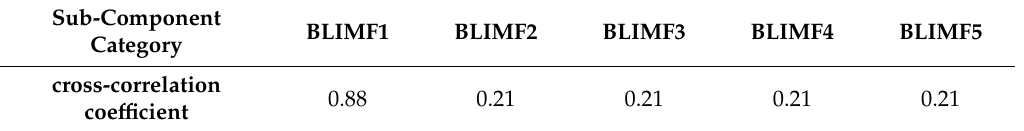
Table 1. Statistics of the correlation coe ffi cient between di ff erent sub-components and the original signal.